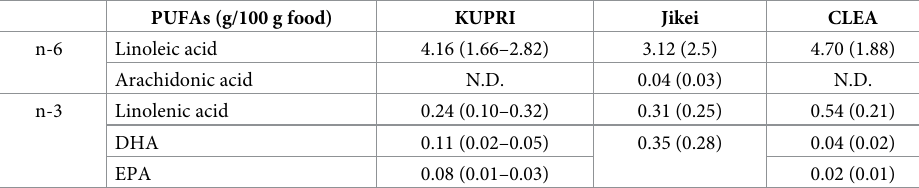
Table 1. The concentration of PUFAs contained in diet.